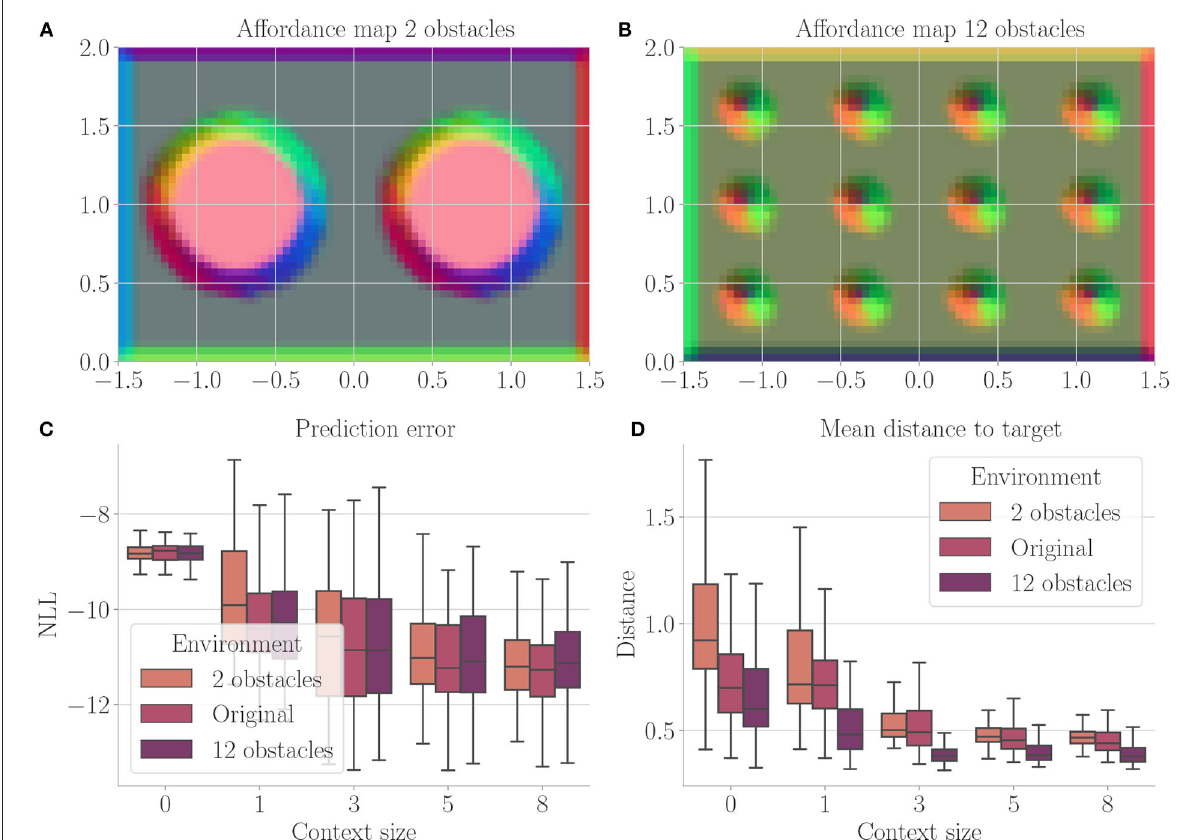
FIGURE7 Results from Experiment II–Generalization (Section 4.4). For each setting, the results are aggregated over 25 differently initialized models which each performed 4 goal-directed control runs for 200 time steps. The box plots show the medians (horizontal bars), quartiles (boxes), and minima and maxima (whiskers). Data points outside of the range defined by extending the quartiles by 1.5 times the interquartile range in both directions are ignored. “Original” refers to the environment from Experiment I (Section 4.3). (A) Exemplary affordance map for context size 8 from the environment with 2 obstacles. To generate this map, we probed the environmental map at every sensible location, applied the vision model to each output, performed dimensionality reduction to 3 via PCA, and interpreted the results as RGB values. (B) Exemplary affordance map for context size 8 from the environment with 12 obstacles. (C) Prediction error during goal-directed control on all three environments. It is the negative log-likelihood of the actual change in position in the transition model’s predicted probability distribution. (D) Mean distance to the target during goal-directed control in all three